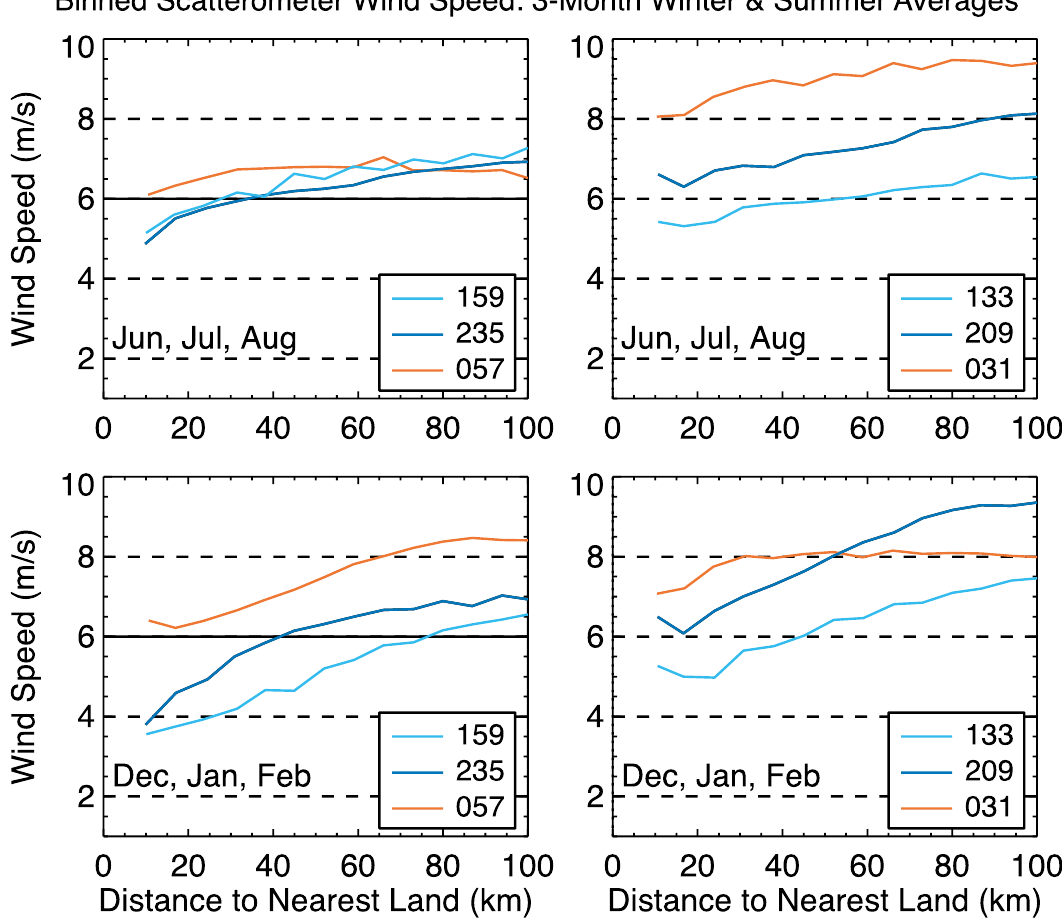
Figure 6. As in Figure 5 except showing QuikSCAT wind speeds binned according to the distance of the individual wind retrievals to the nearest land. Bins are again divided into 7 km distances (7 – 13, 14 – 20, etc.). The blue dots in Figure 7 show the retrievals within 7 – 13 km of any land and within 6.5 km of the altimeter track. Above data points closest to the coast are the averages of the blue dots in Figure 7.